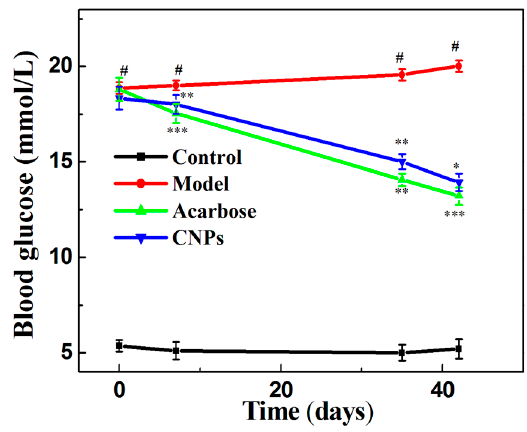
Figure 4. Effects of as ‐ prepared CNPs and acarbose on blood ‐ glucose levels in mice. Data ware expressed as mean ± standard deviation ( n = 8), # p < 0.001 vs. control, * p < 0.05, ** p < 0.01, *** p < 0.001 vs. model.